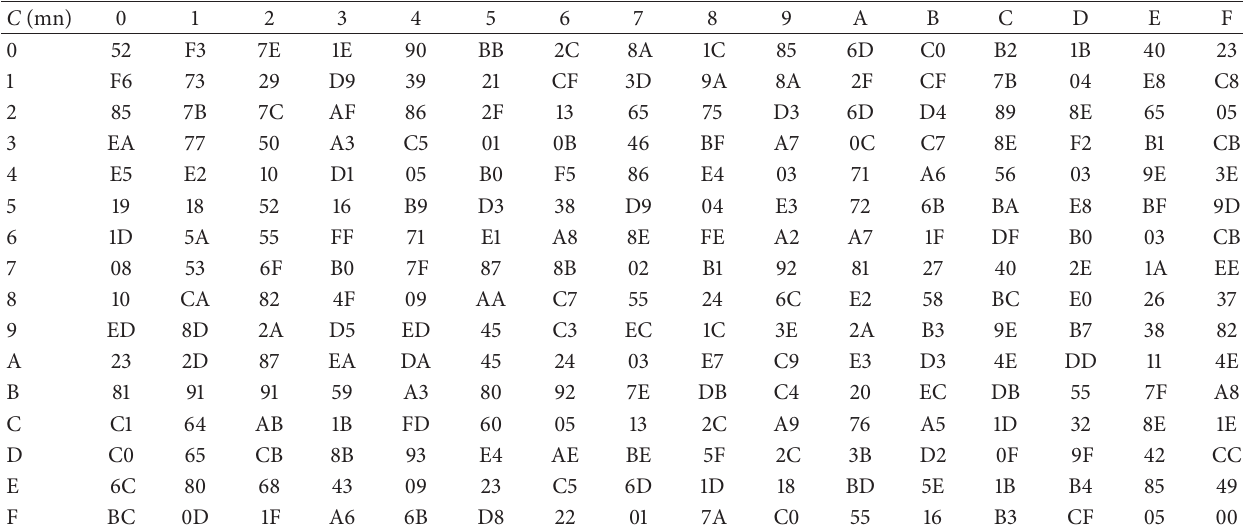
Table 1: Coefficients of algebraic expression of AES inverse S -box